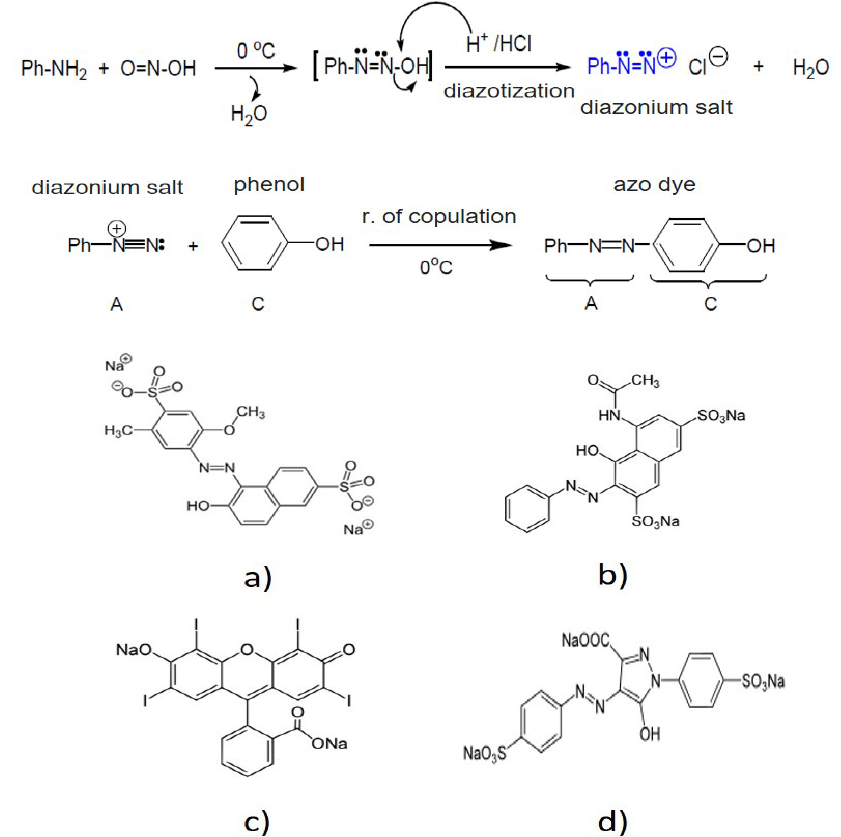
Figure 2. Chemical reactions involved in the production of azo dyes, and chemical structure of dyes. ( a ) Red 40, ( b ) Red 2, ( c ) Red 3, ( d ) Yellow 5.